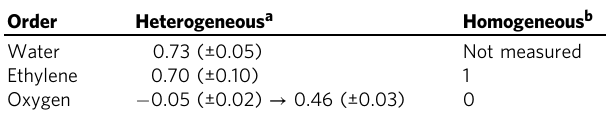
Table 1 Comparison of homogeneously and heterogeneously catalyzed Wacker oxidation.